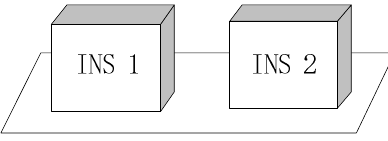
Figure 1. Schematic diagram of system installation.